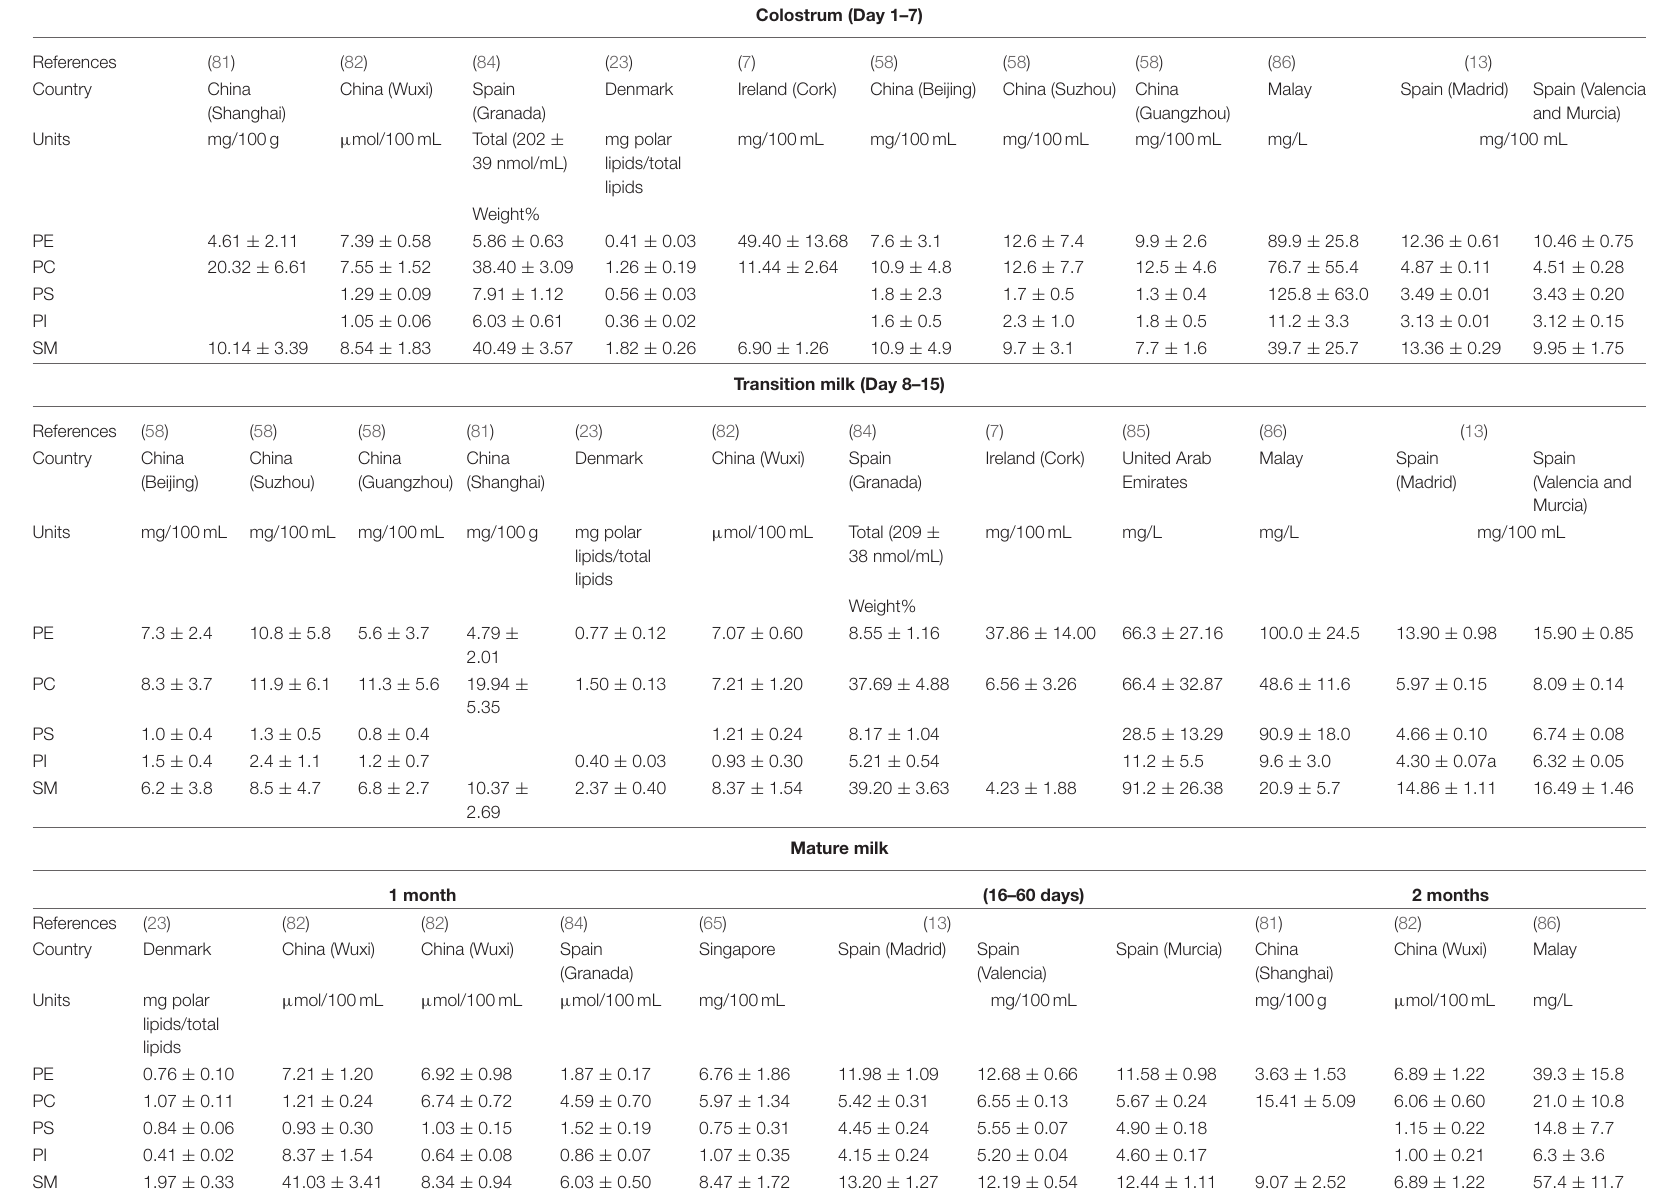
TABLE 2 | Concentration of phospholipid species in human colostrum, transitional, and mature